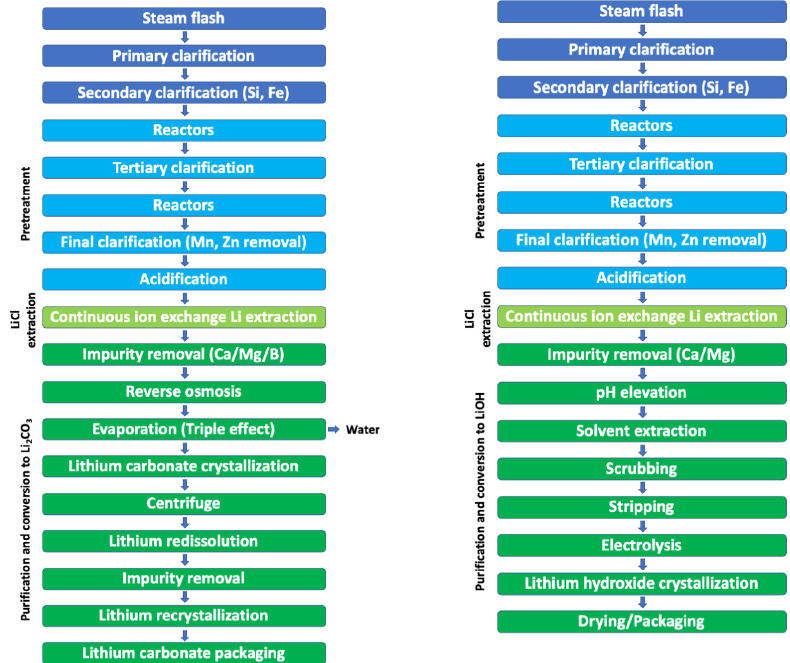
Figure 24. EnergySource patented process for extraction of lithium and other valuable materials from geothermal brines from [133–135]. The process train includes pretreatment, lithium chloride extraction and recovery by continuous counter-current ion exchange, followed by purification and conversion of lithium chloride to saleable products, either lithium carbonate or lithium hydroxide. See Featherstone et al. [133–135] for a complete description of the process flow diagrams. This process is marketed as the ILiAD Process [279].